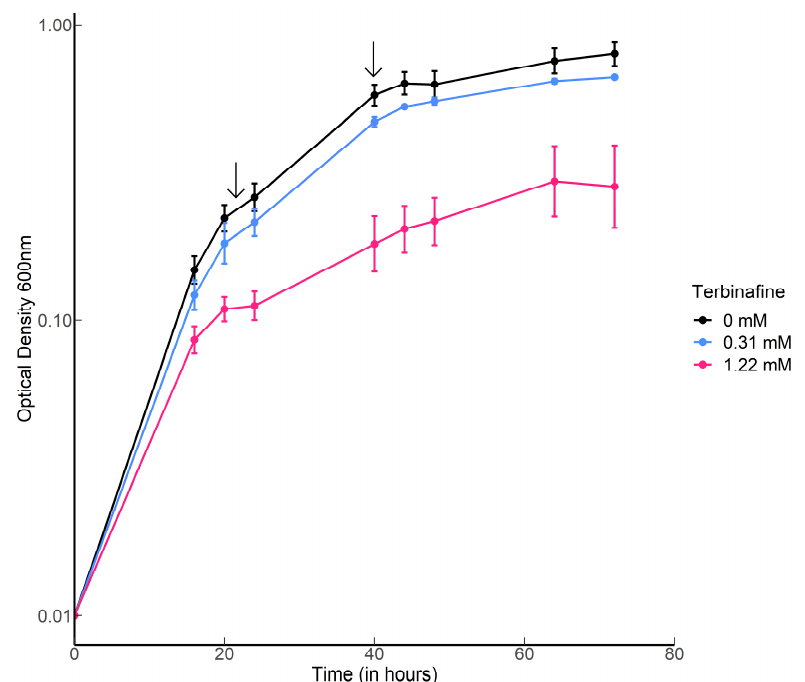
Figure 2. Growth curves of S. acidocaldarius with and without terbinafine: Error bars represent the standard error of the mean. Black arrows indicate the time points for harvesting the cells for lipid extraction.